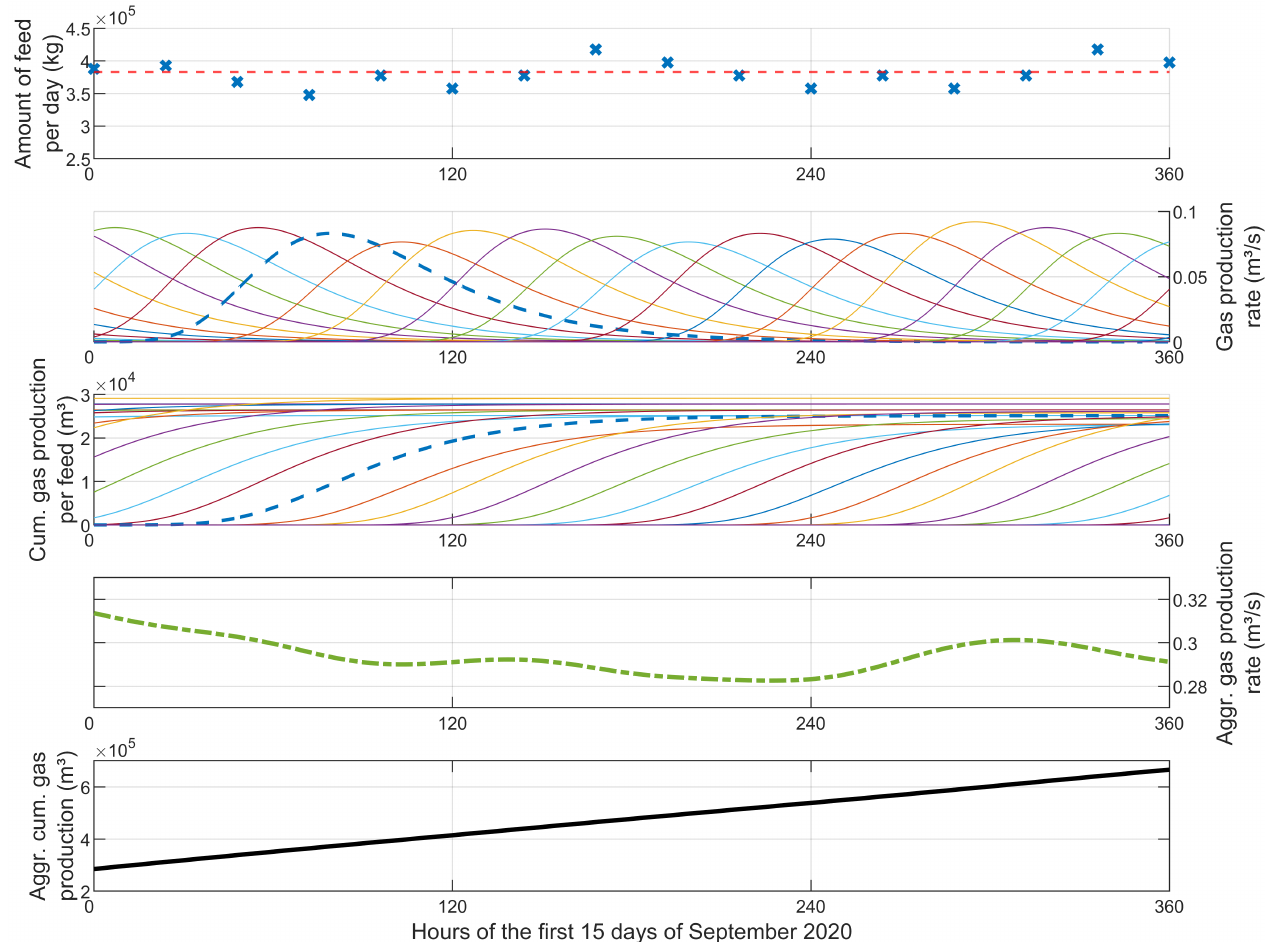
Figure 6. Biogas production dynamics for specific feeding instances over the first half of the simulation horizon. First plot: feeding instances and mean feeding amount throughout the month; second plot: biogas production rate per feeding instances; third plot: cumulative gas production per feeding instance; fourth plot: aggregated biogas production rate; fifth plot: aggregated cumulative biogas